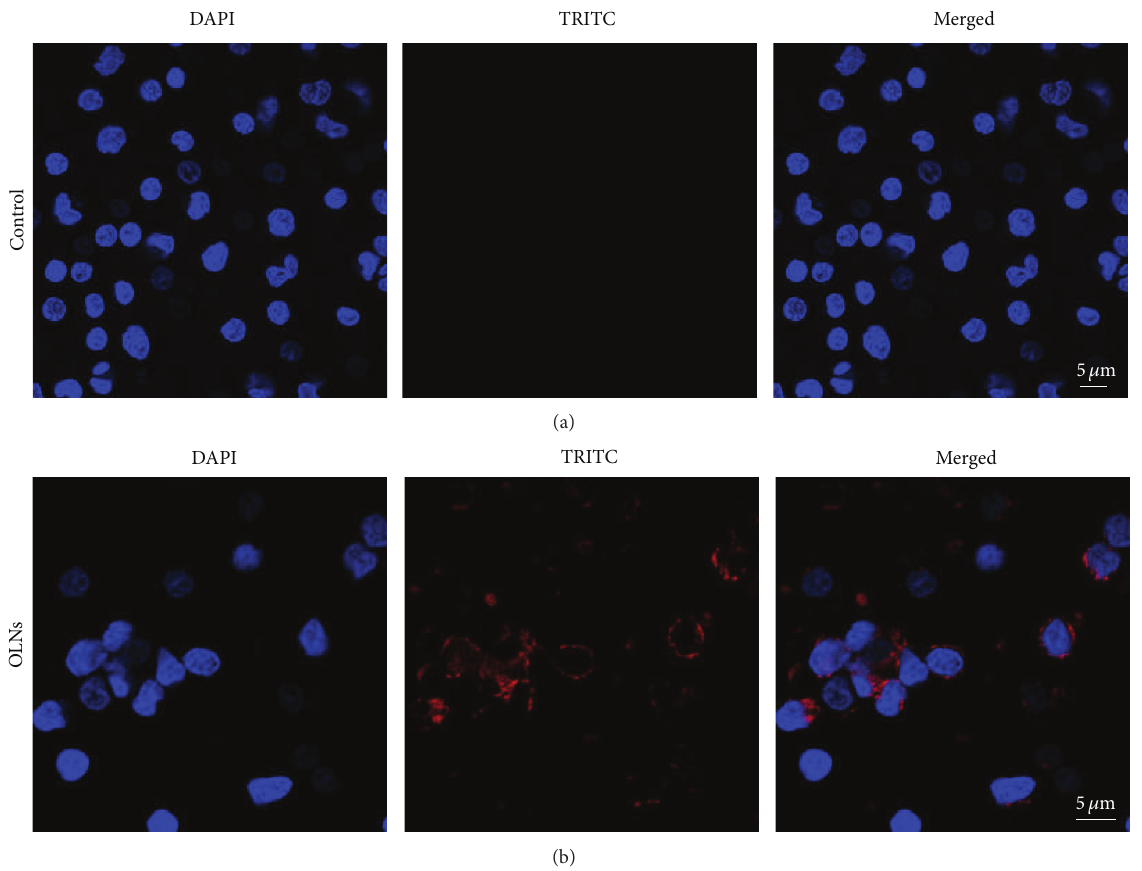
Figure 2: OLN internalization by human monocytes. Human adherent monocytes (10 6 cells/2 mL Panserin 601 medium) were left untreated (a) or treated with 200 𝜇 L rhodamine B-labeled dextran-shelled OLNs (b) for 24 h in normoxia (20% O 2 ). After DAPI staining, cells were checked by confocal microscopy. Results are shown as representative images from three independent experiments. Left panels: cell nuclei after DAPI staining (blue). Central panels: rhodamine B-labeled dextran-shelled OLNs (red). Right panels: merged images. Magnification: